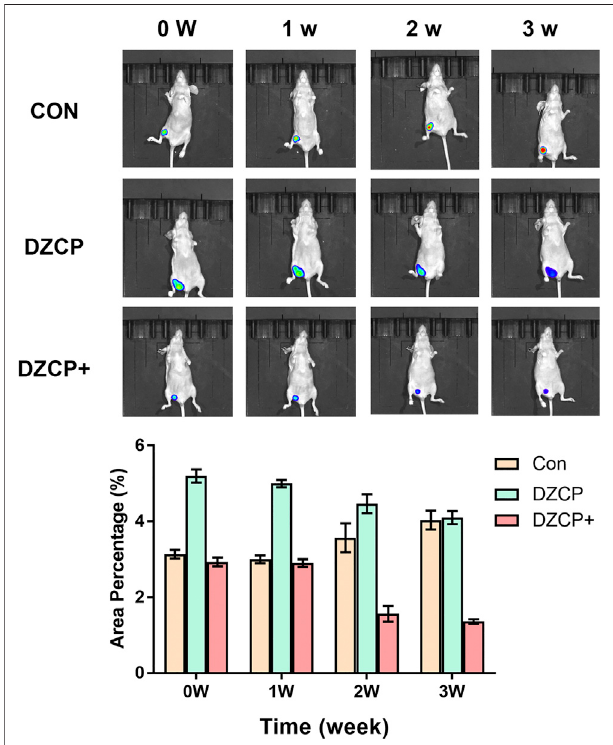
FIGURE 6 | In vivo imaging of mice at 0, 1, 2, and 3 weeks after tail vein injection of PBS, DZCP nanoparticles, and DZCP nanoparticles with SDT,